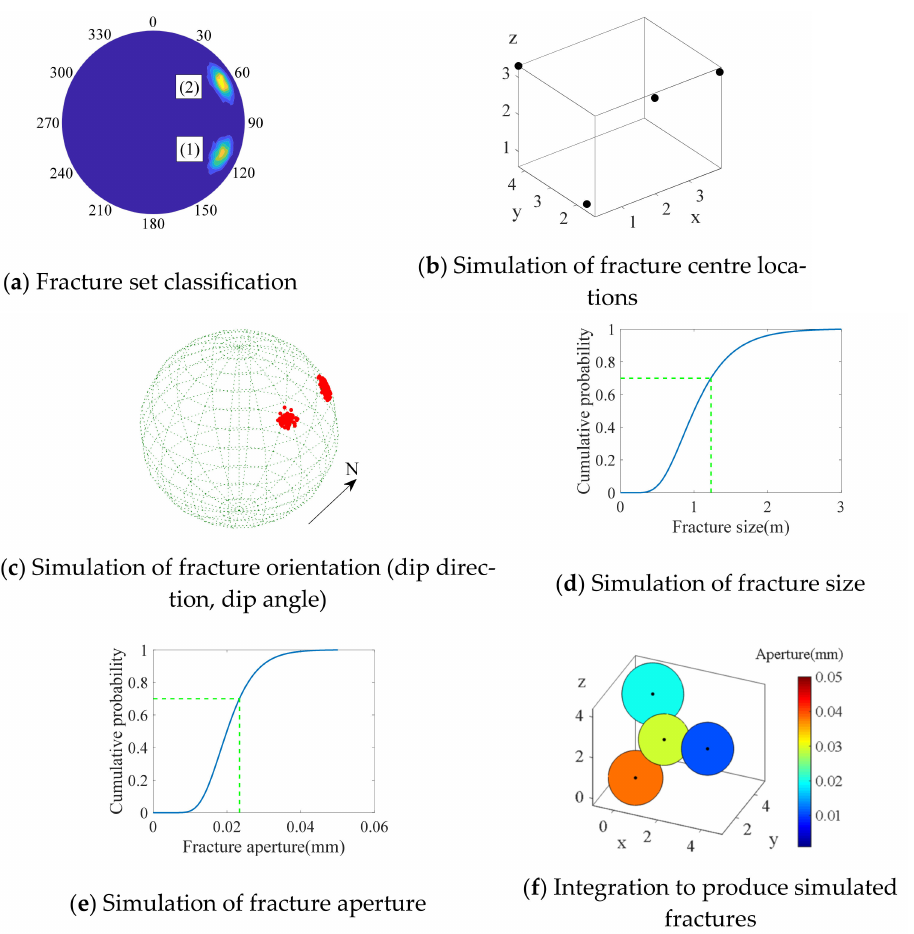
Figure 2. Workflow of the MPP modelling method. ( a ) Fracture set classification, ( b ) Simulation of fracture centre locations by a point process, ( c – e ) Simulations of fracture properties such as strikes (or dip directions), dips, sizes, and apertures, ( f ) Integration of fracture locations and properties to produce final simulated